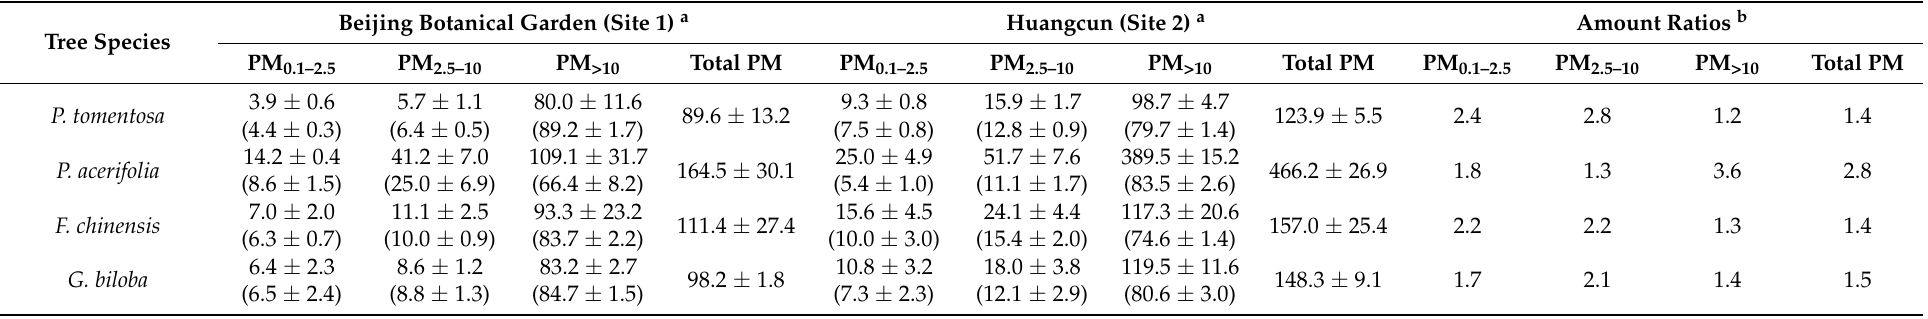
Table 1. Particulate matter and its size fractions accumulated on unit leaf area of trees ( µ g/cm 2 ), size fraction percentage (%, shown in parenthesis), and the amount ratios (%) as compared between Beijing Botanical Garden (Site 1) and Huangcun (Site 2).